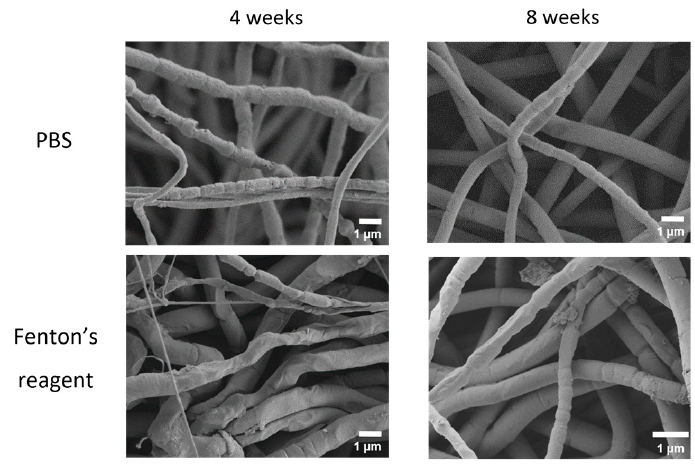
Figure 5. SEM images of electrospun PLA mats after 4 and 8 weeks of incubation in PBS and in Fenton’s reagent.